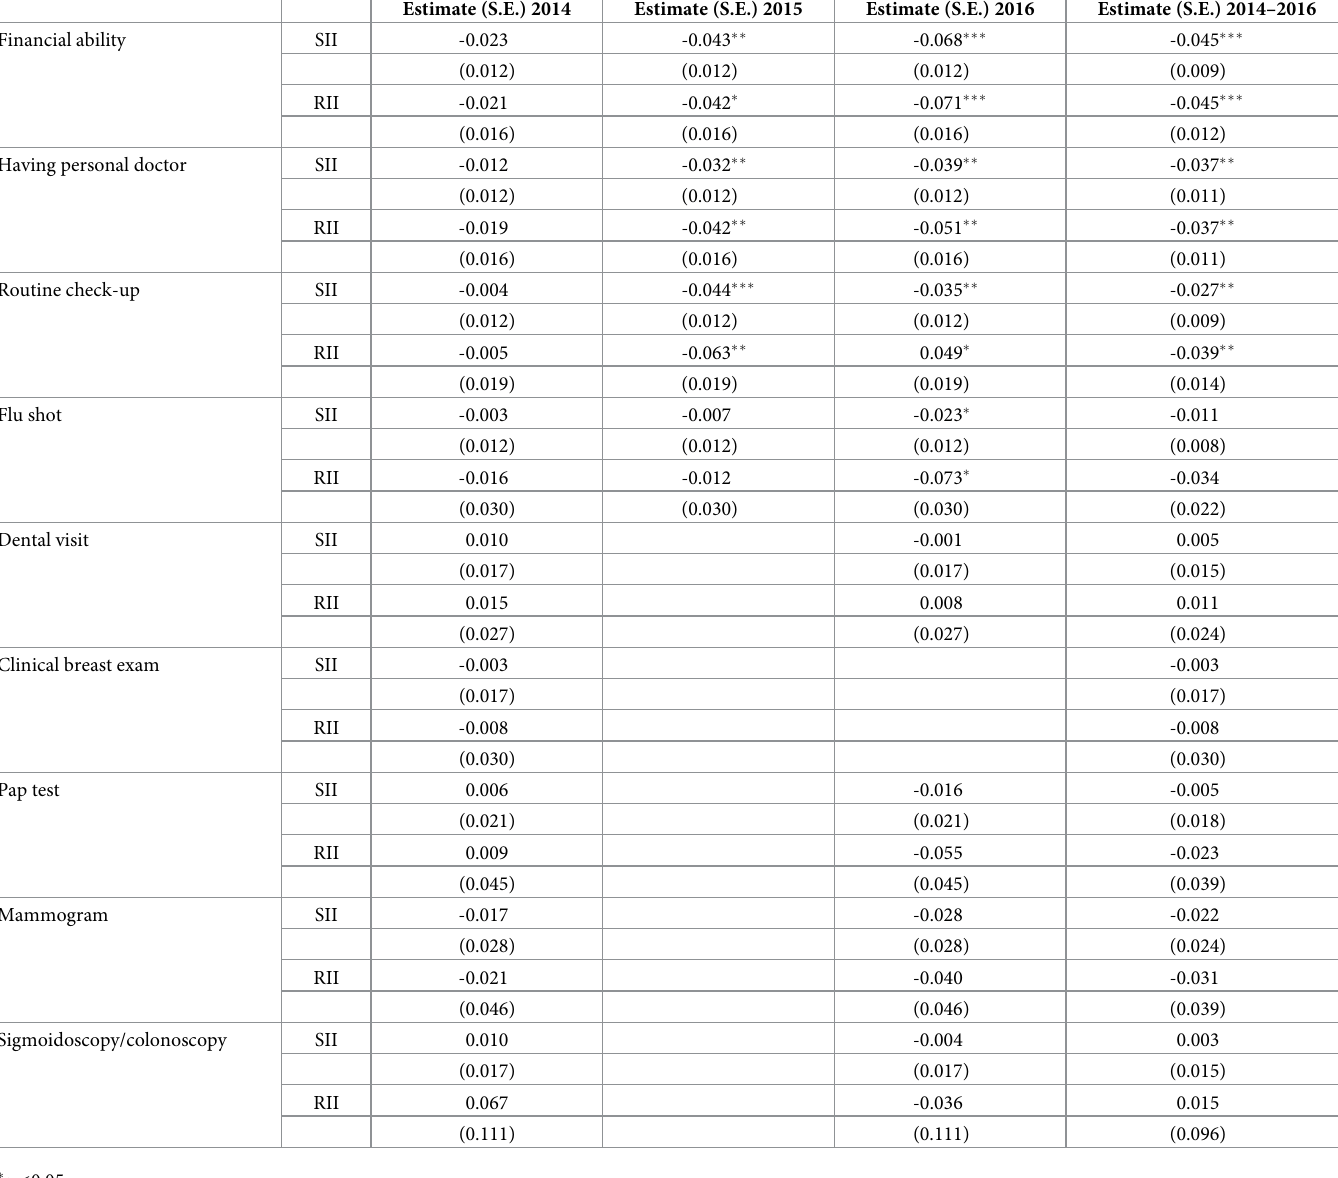
Table 2. Difference-in-Differences estimates of Medicaid expansion implementation in SII and RII for use of health services. Estimate (S.E.)